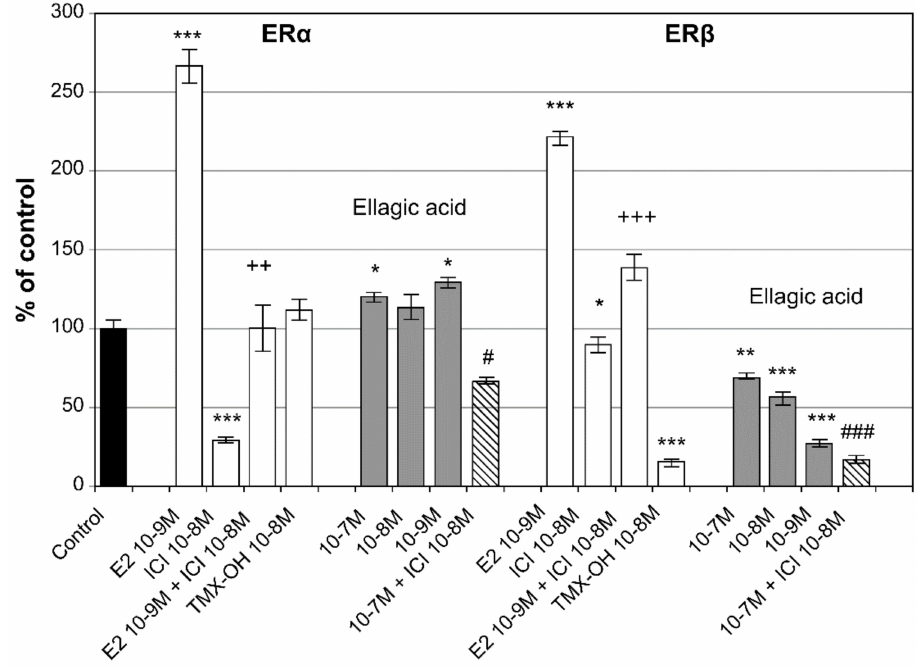
Figure 7. Effect of ellagic acid on estrogen receptor levels in HeLa cells transfected with EREs- containing reporter plasmid with ER α or ER β , respectively. * Significantly different from con- trol (* p < 0.05, ** p < 0.01, *** p < 0.001). + Significantly different from E 2 10 − 9 M ( ++ p < 0.01, +++ p < 0.001). # Significantly different from ICI182780 10 − 8 M ( # p < 0.05, ### p < 0.001). Reprinted from Papoutsi, Z.; Kassi, E.; Tsiapara, A.; Fokialakis, N.; Chrousos, G.P.; Moutsatsou, P. Evaluation of